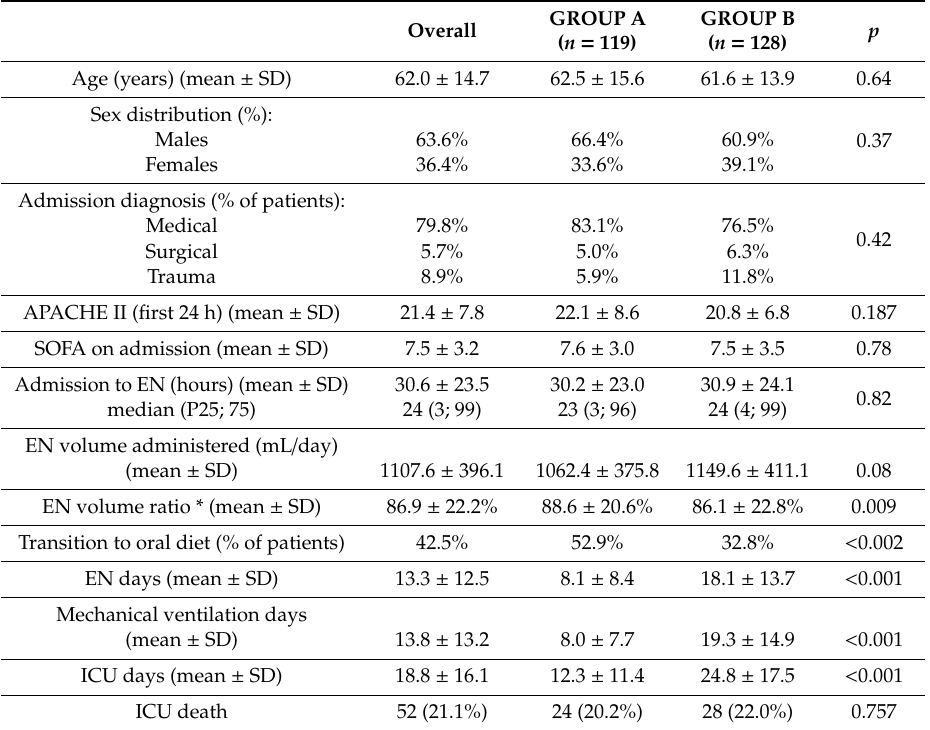
Table 1. Demographic, enteral nutrition and outcome variables recorded in critically ill, mechanically ventilated patients without (group A) and with gastrointestinal complications (group B).